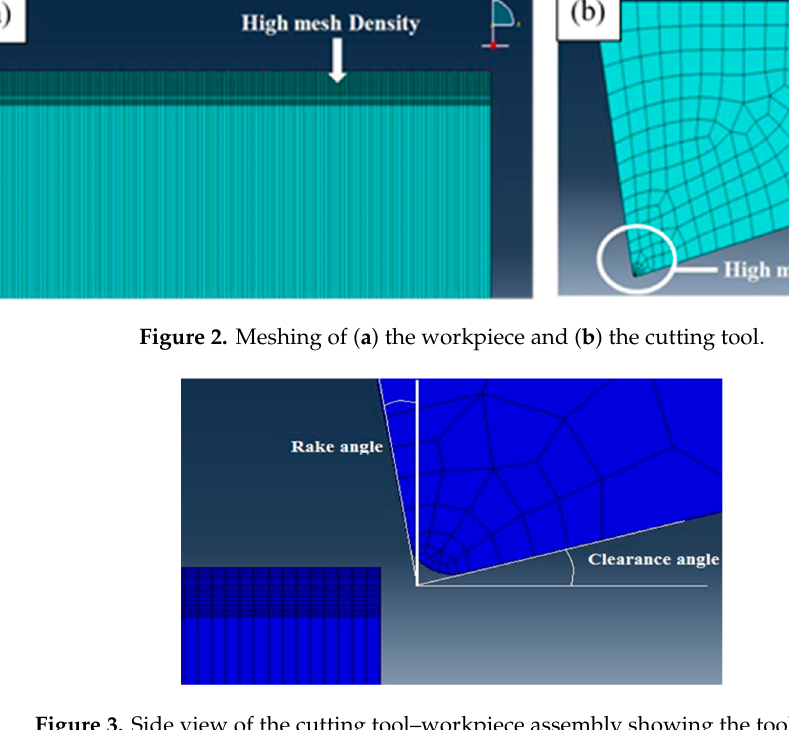
Figure 2. Meshing of ( a ) the workpiece and ( b ) the cutting tool.